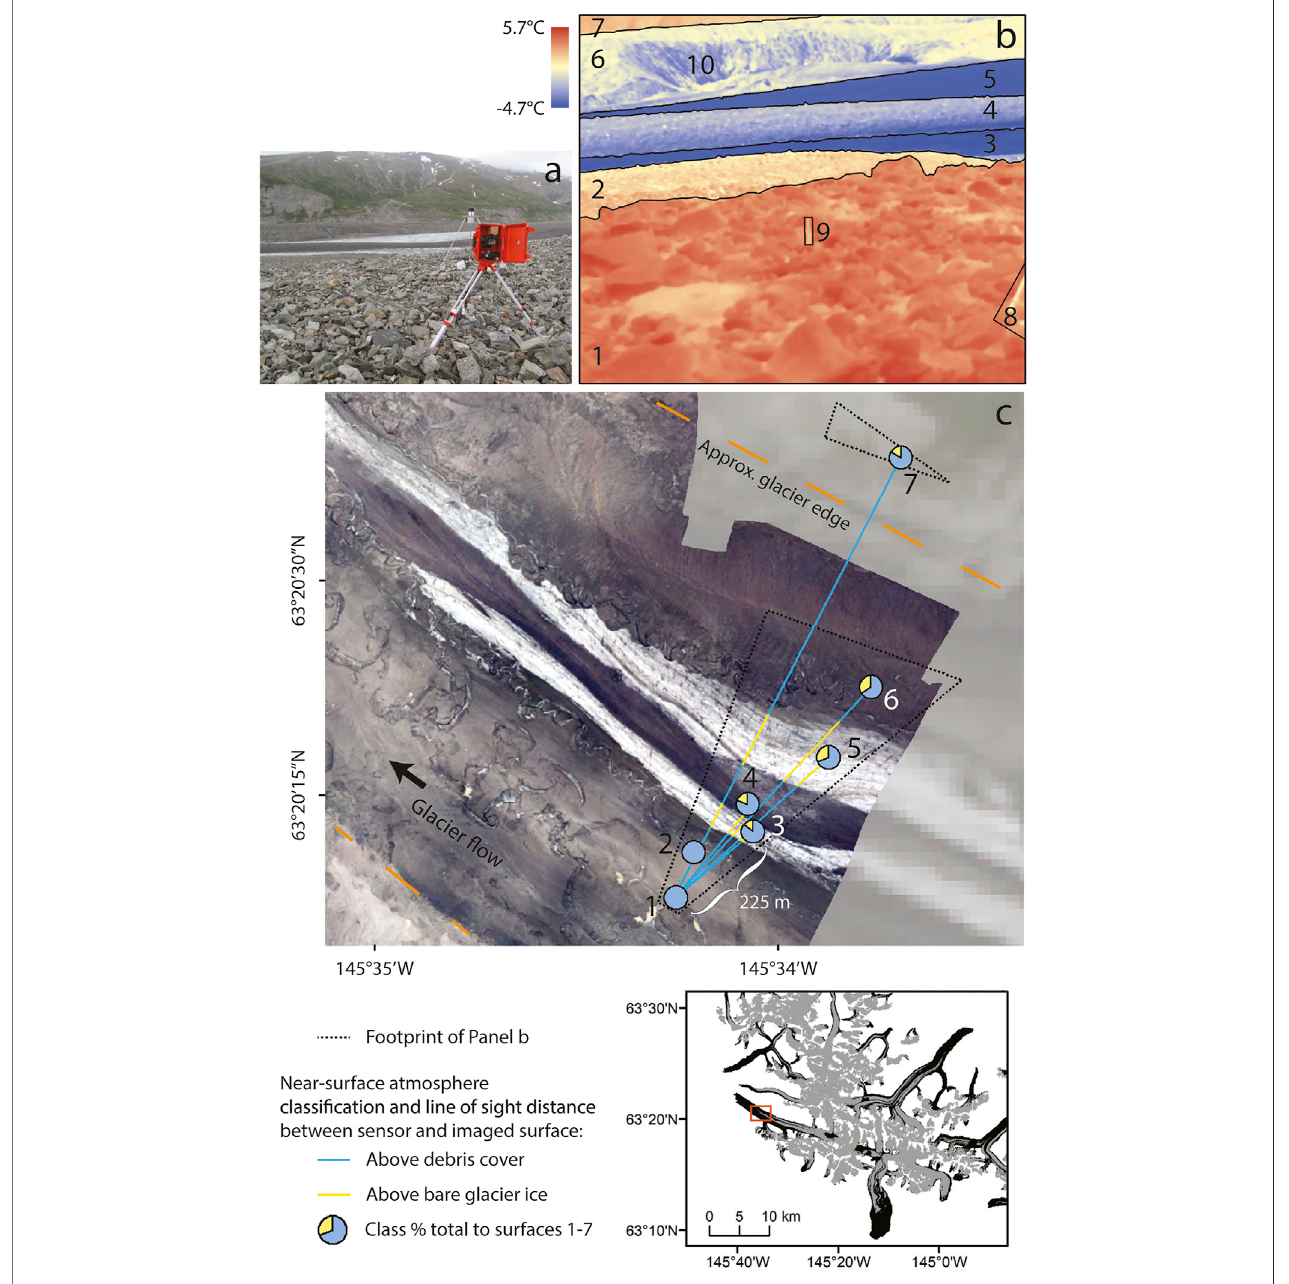
FIGURE 1 | (A) thermal camera in position to capture (B) . (B) one (unprocessed) frame of the thermal time-series with black lines de fi ning image segments (1 – 7) described in Section 3.1 . (8) is the corner of a weather station structure and (9) is an aluminum ablation stake, both were cut out of each thermal image to not in fl uence segment statistics. (10) is the side of a medial moraine with a thinly debris-covered, or proto, ice cliff visible. The nadir footprint of (B) is shown in (C) and one to seven correspond to their respective image segments. The line of sight distance is shown between the thermal camera [10 m away from (1)] and the seven segments. Ablation was measured at (1) – (5) where the atmospheric classi fi cation pie is centered over the ablation measurement location.